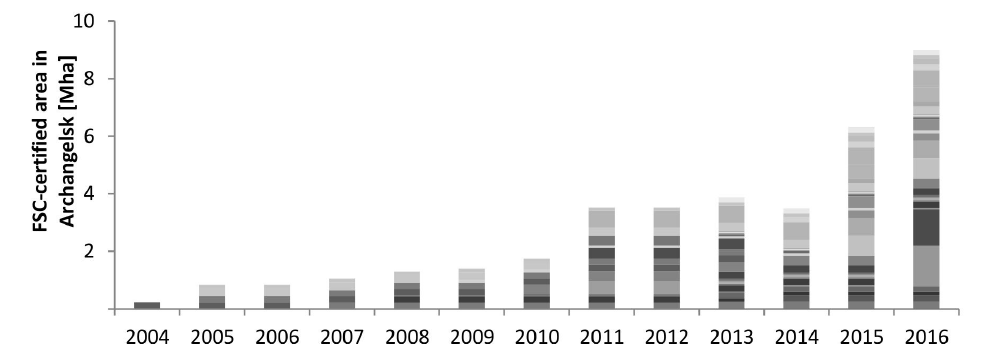
Figure 4. Spatial coverage of FSC-certified timber companies in the Arkhangelsk Region between the beginning of its implementation in 2004 until 2016 [52]. Different levels of grey represent each of the 41 FSC-certified